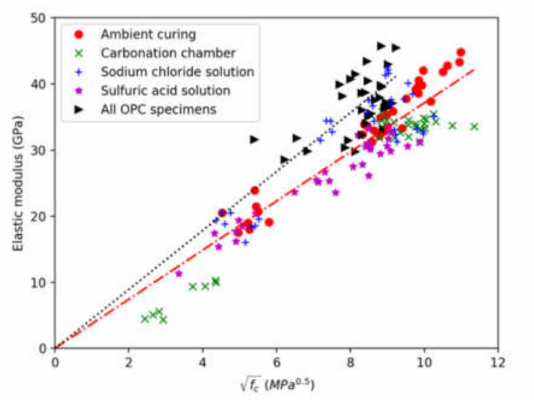
Figure 7. The relationship between elastic modulus and the compressive strength ( f c ). Note that only alkali-activated fly ash and slag (AAFS) specimens were di ff erentiated for